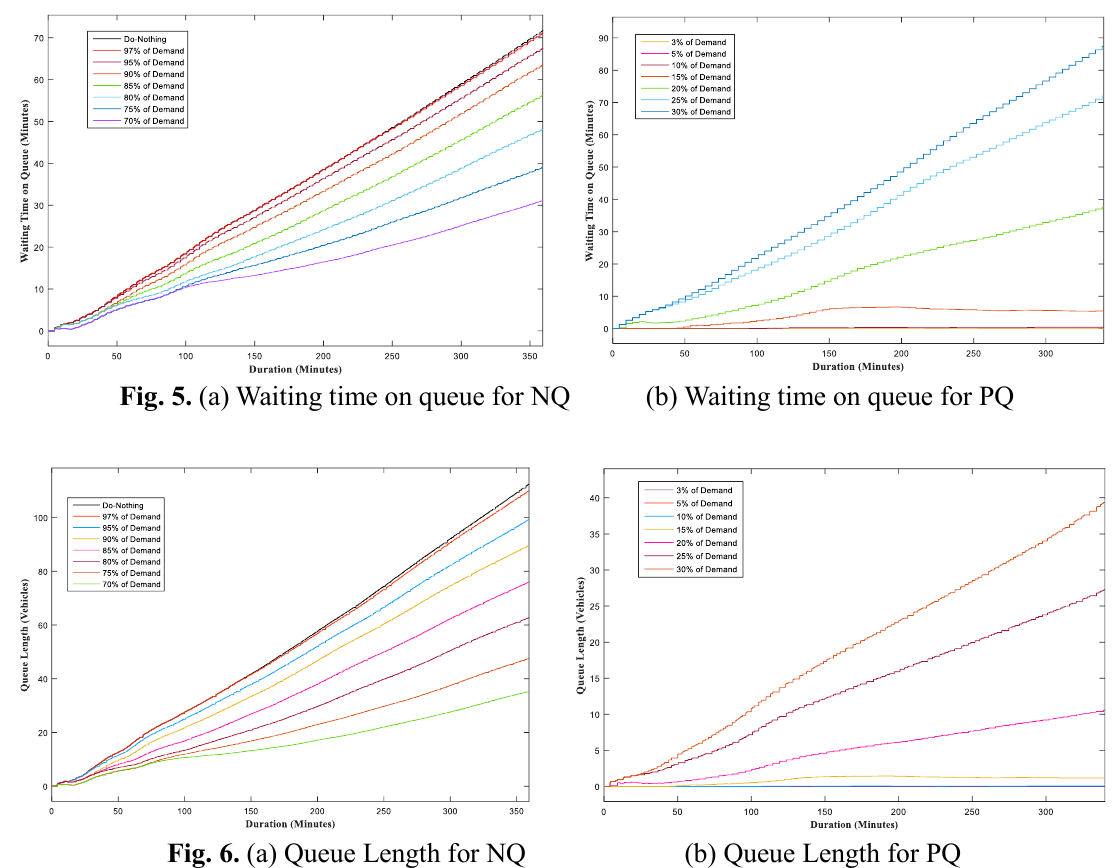
Fig. 6. (a) Queue Length for NQ (b) Queue Length for